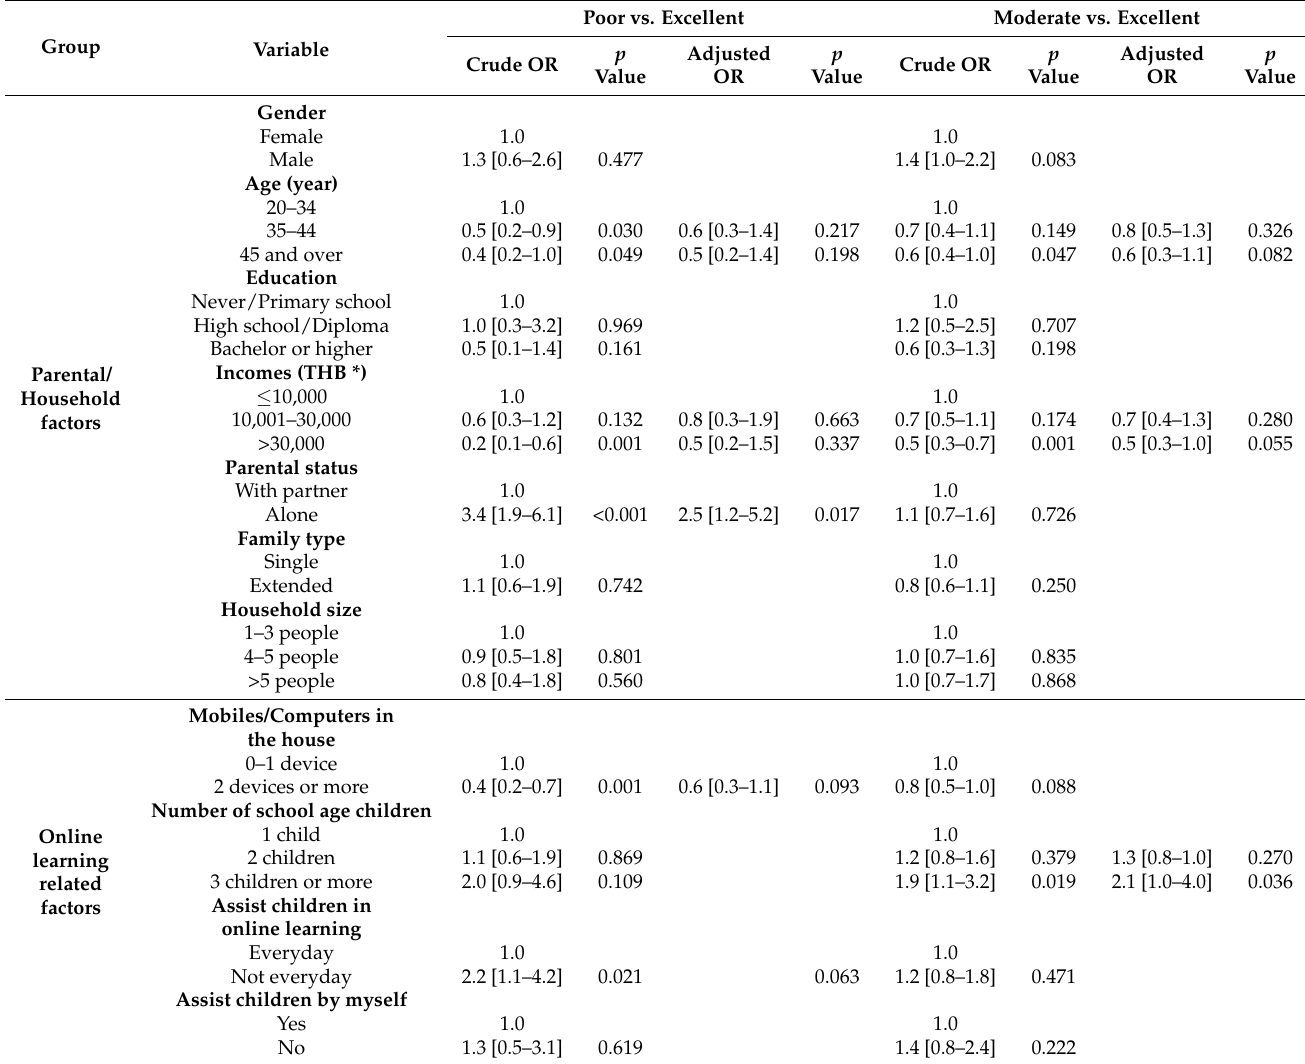
Table 4. Multinomial logistic regression on family health among Thai families with primary school children during the COVID pandemic in